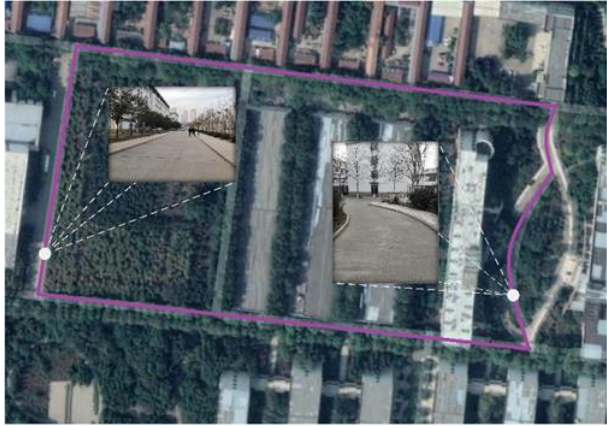
Figure 7. Schematic of the experimental route.